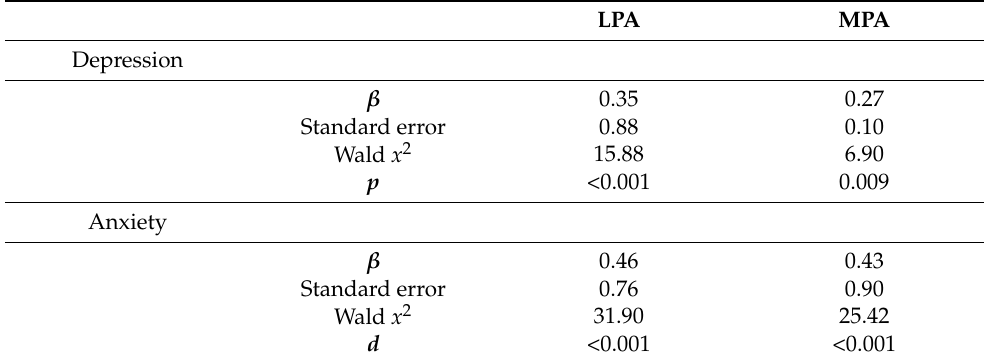
Table 5. Generalized linear model parameter estimation ( n =